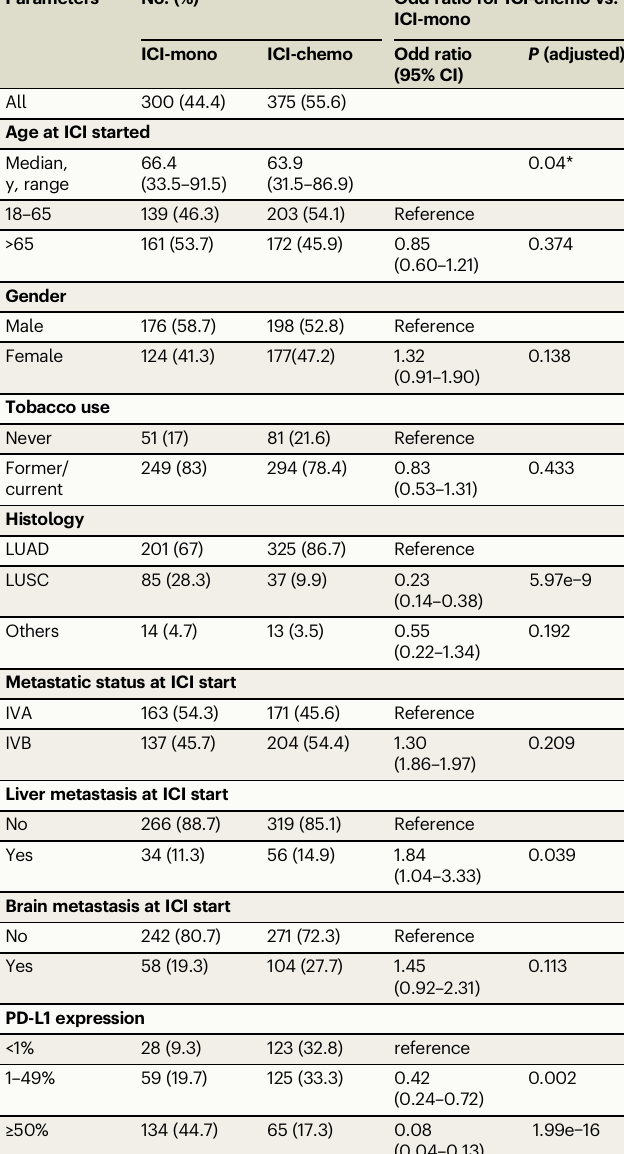
Table 2 | Clinicopathologic features of patients treated with fi rst-line ICI-mono vs ICI-chemo in MDACC ( n = 675) Parameters